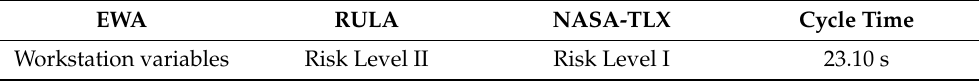
Table 5. Summary of assessed results to be modeled.